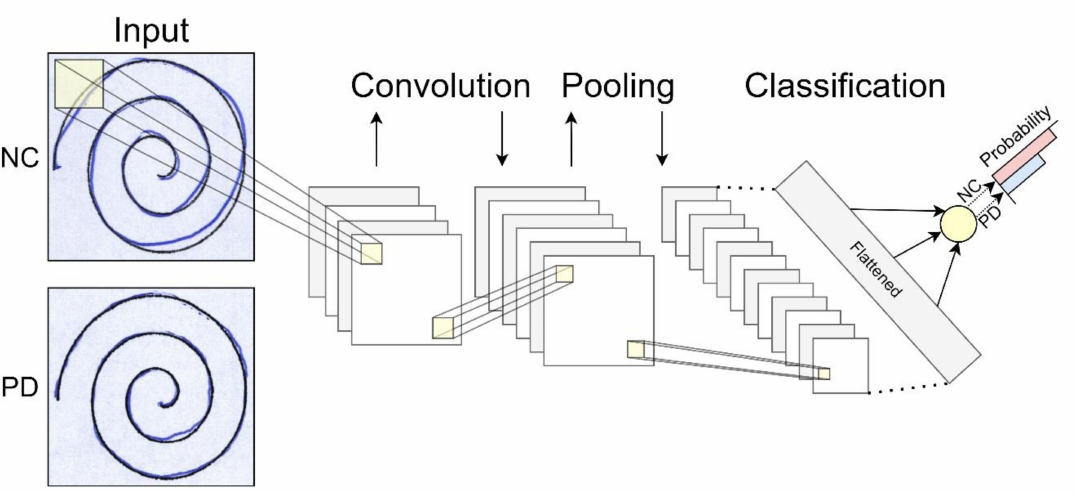
Figure 3. Deep Learning handwritings classification. CN and PD handwritings are hard to distinguish if not trained to. A CNN can be made capable of classifying patients and controls upon almost imperceptible changes in subjects’ drawings. Convolution and pooling operations process input data to extract relevant features from the images, allowing detection of group differences. Spirals images were taken from the NewHandPD dataset [35], available at http://wwwp.fc.unesp.br/ ~papa/pub/datasets/Handpd/, accessed on 5 January